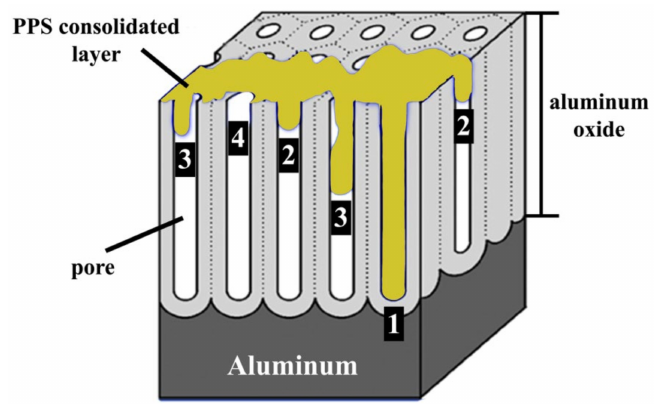
Figure 9. Schematic illustration of aluminum oxide after PAA pre-treatment, adapted from [51], and the proposed model of pore filling by the PPS. ( 1 ) Complete wetting and pore filling, ( 2 ) complete wetting, incomplete pore filling, ( 3 ) partial wetting and incomplete pore filling, and ( 4 ) no wetting and no pore filling.